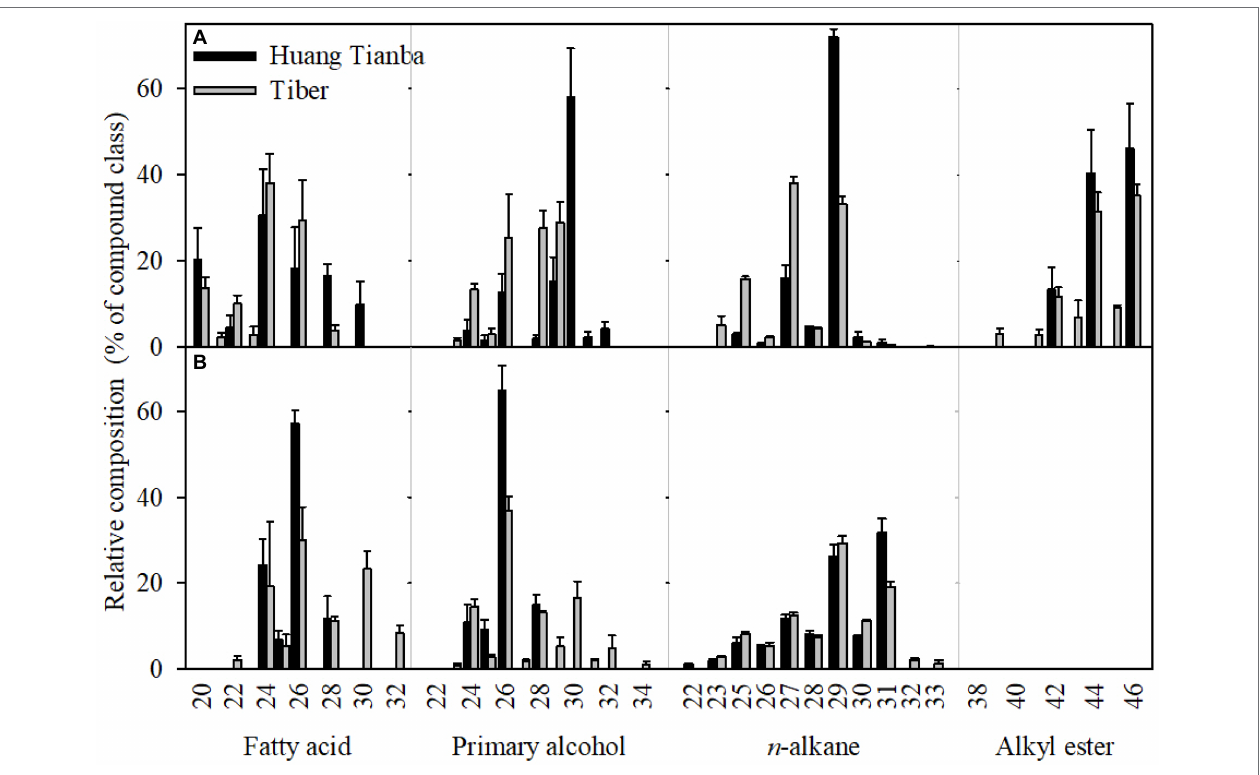
FIGURE 7 | Carbon chain-length distribution of the cuticular waxes on the inner tepals (A) and leaves (B) of the Lilium cultivars ‘Huang Tianba’ and ‘Tiber’. Data are presented as the mean ± standard deviation ( n =